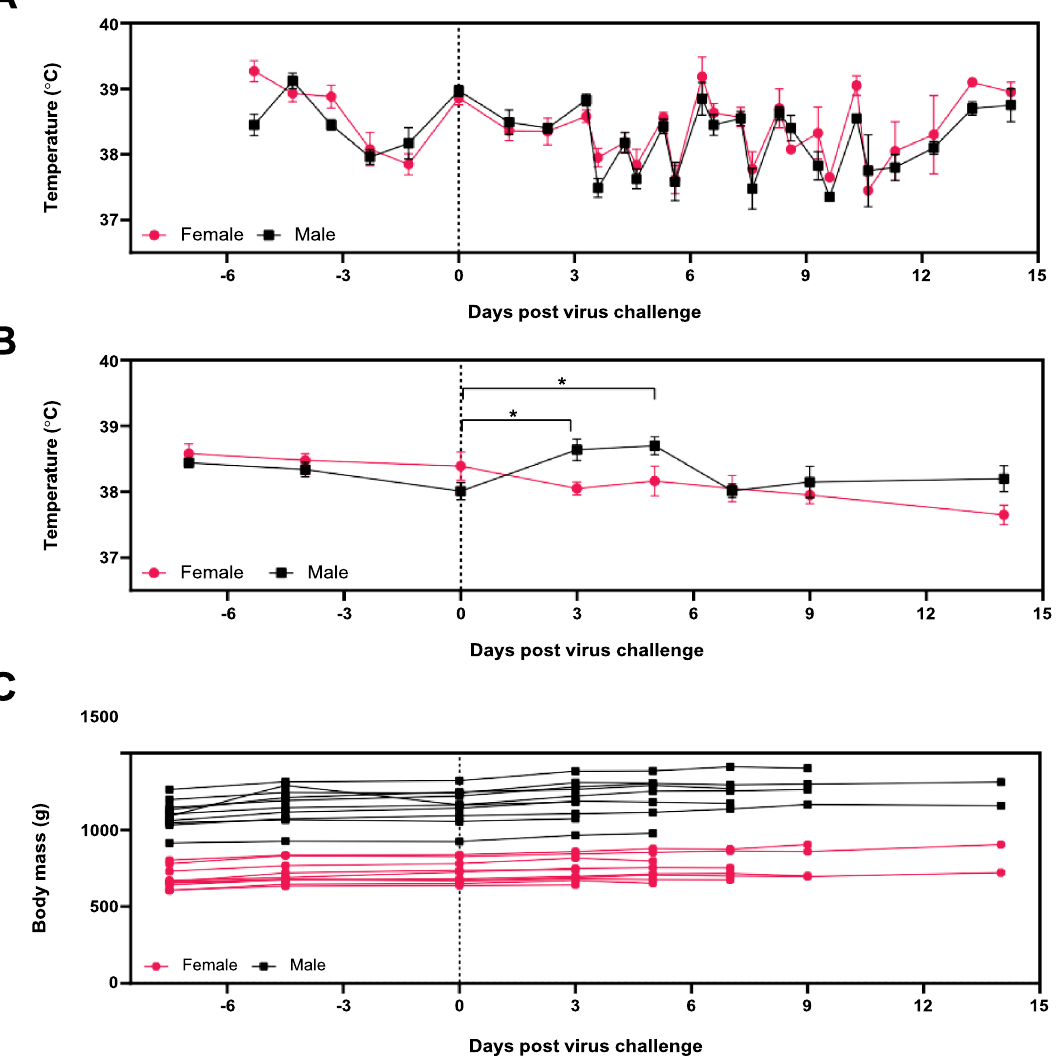
Figure 1. Clinical Observations of ferrets after SARS-CoV-2 challenge. ( A ) Ferrets were observed at least once a day, with twice a day monitoring (approximately 6 h apart) from day 3 onwards. Temperatures were taken during routine clinical monitoring using the identifier microchip on all days apart from the day of virus challenge. Data points indicate mean temperatures ± SEM. ( B ) Rectal temperatures were taken during the enrolment/acclimatisation phase, and at day 3, 5, 7, 9, and 14 while ferrets were anaesthetised. Data points indicate mean rectal temperatures ± SEM. Statistical significance indicated by * (p < 0.05). ( C ) Ferret body weight was recorded while anaesthetised at day − 7, − 4, 0, 3, 5, 7, 9, and 14 days post virus challenge. Points and lines represent individual animals. In each of the panels, black squares indicate male animals and rose-coloured circles indicate female